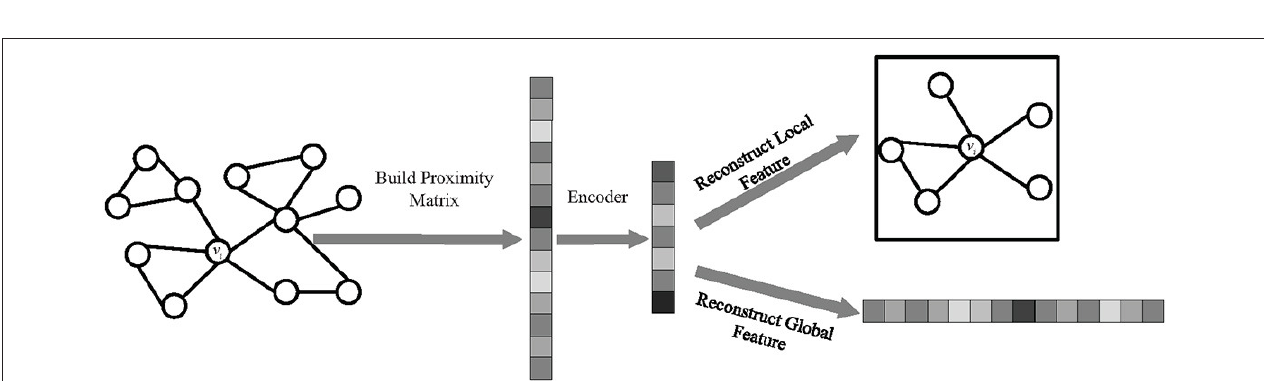
FIGURE 2 | The framework of MLNE.